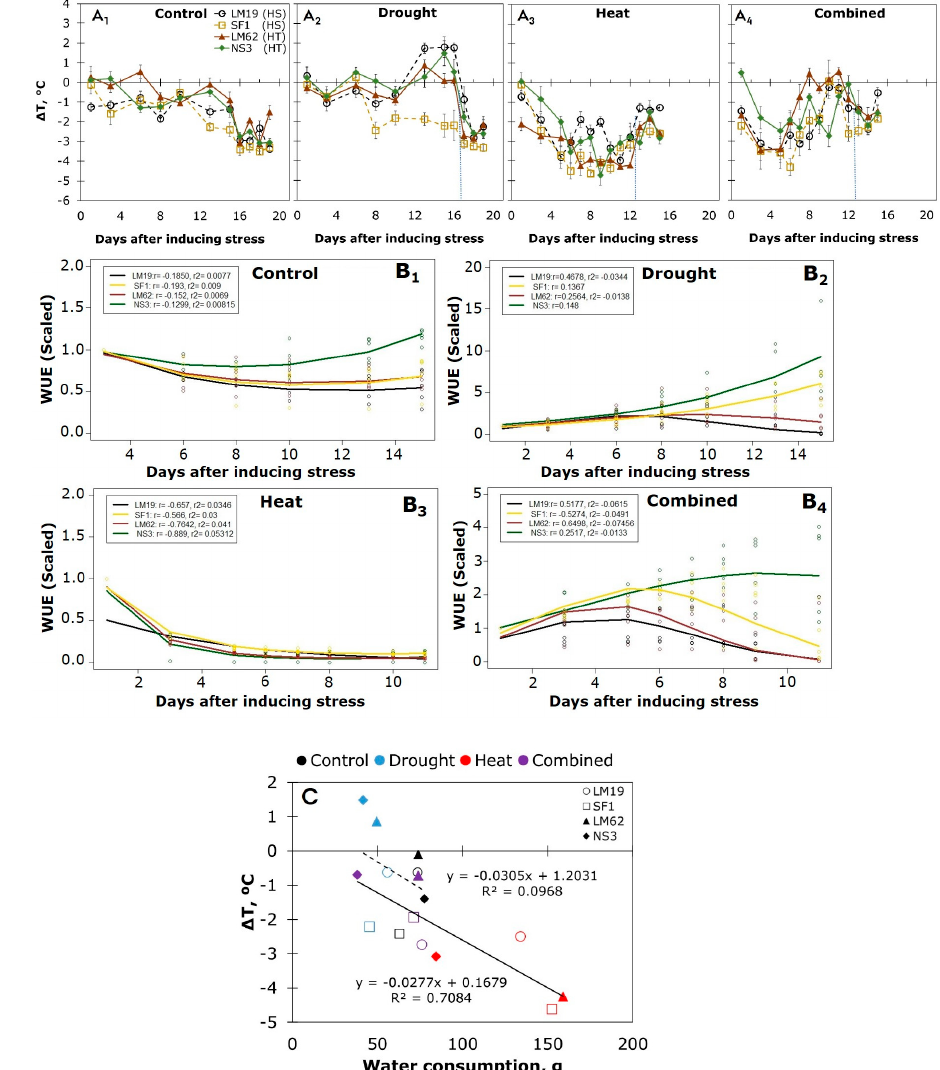
Figure 6. Canopy temperature. ( A 1–4 ) Difference between canopy average and air temperature measured in the thermal IR imaging unit ( Δ T) at day 1 before inducing the stress and along days after inducing the stress treatments, followed by three days of recovery in four wheat genotypes. HS represents heat-sensitive genotypes (open symbols, dashed lines) and HT represents heat-tolerant genotypes (closed symbols, solid lines). Blue dotted line denotes the recovery phase. The data represent mean values ± S.E.M. ( n = 5). ( B 1–4 ) Growth models for water use efficiency ( WUE ) in different treatments. Bold lines represent the models and the circles point out the scaled data. In the legends, the estimated coefficients of the growth models are presented (Equations (1) and (2) described in materials and methods). ( C ) Correlation between Δ T and water consumption at the last day of four different treatments in each wheat genotype. The linear dashed line represents control and drought treatments and the linear solid line represents heat and combined stress treatments. R 2 values represent the level of fit for the linear regressions ( n = 4).